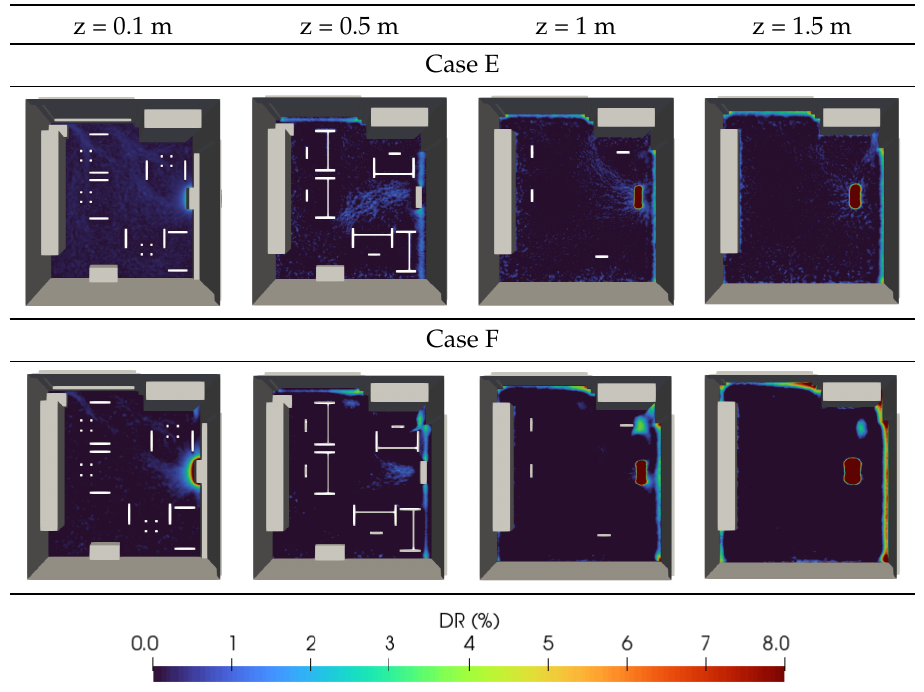
Figure 14. Winter heating condition. Draught-rate profile on different sections in the z direction obtained with low input air velocity (Case E) and high input air velocity (Case